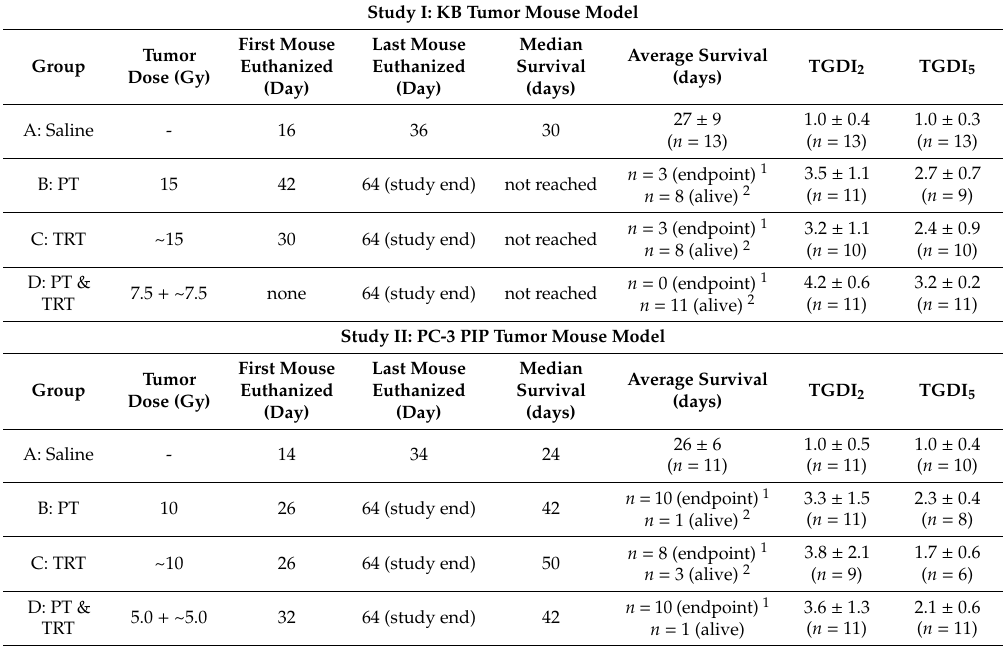
Table 2. Parameters characterizing the e ffi cacy of the applied therapy. (A) Study I: Investigation of KB tumor-bearing CD1 nude mice. (B) Study II: Investigation of PC-3 PIP tumor-bearing BALB / c nude mice.